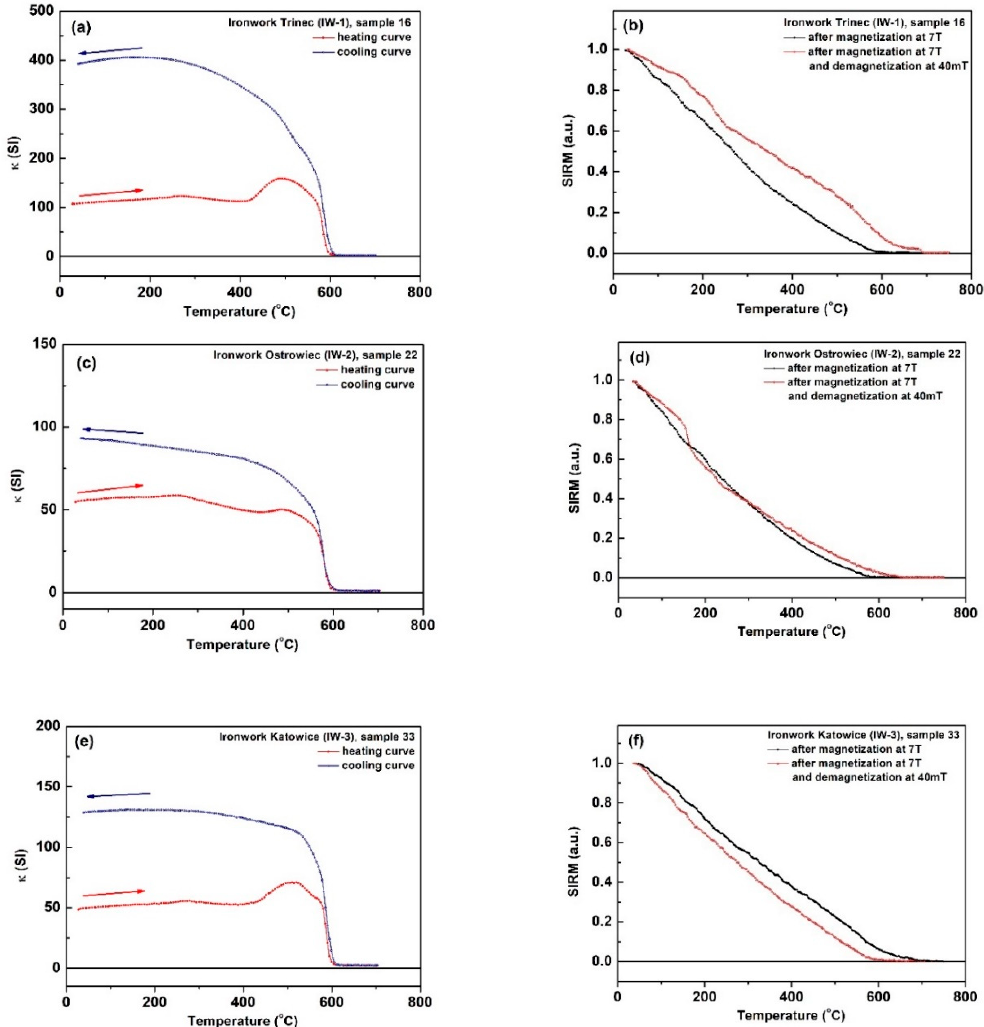
Figure 2. Thermomagnetic curves of magnetic susceptibility— κ (T) for the topsoil samples ( a , c , e ); heating curve (red line) and cooling curve (blue line). Thermal demagnetization of saturation remanent magnetization—SIRM(T) curves for the topsoil samples ( b , d , f ). The black curve obtained after sample saturation at a magnetic field intensity of 7 T; the red curve obtained after saturation at 7 T and demagnetization of low-coercivity phases along three orthogonal axes with a maximum alternating field peak of 40 mT. SIRM(T) curves are normalized to the maximum and minimum values of SIRM. The samples 16 collected from the area nearby Tˇrinec ironworks (IW-1), sample 22 collected from the area nearby Ostrowiec ironworks (IW-2), and samples 33 collected from the area nearby Katowice ironworks (IW-3).